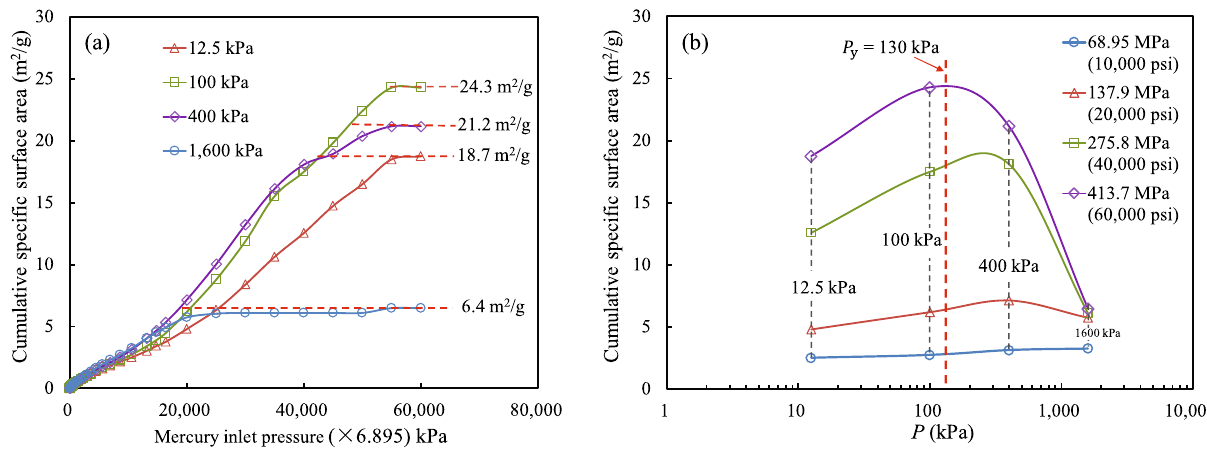
Figure 12. ( a ) Relationship between cumulative specific surface area and mercury inlet pressure. ( b ) Relationship between cumulative specific surface area and consolidation